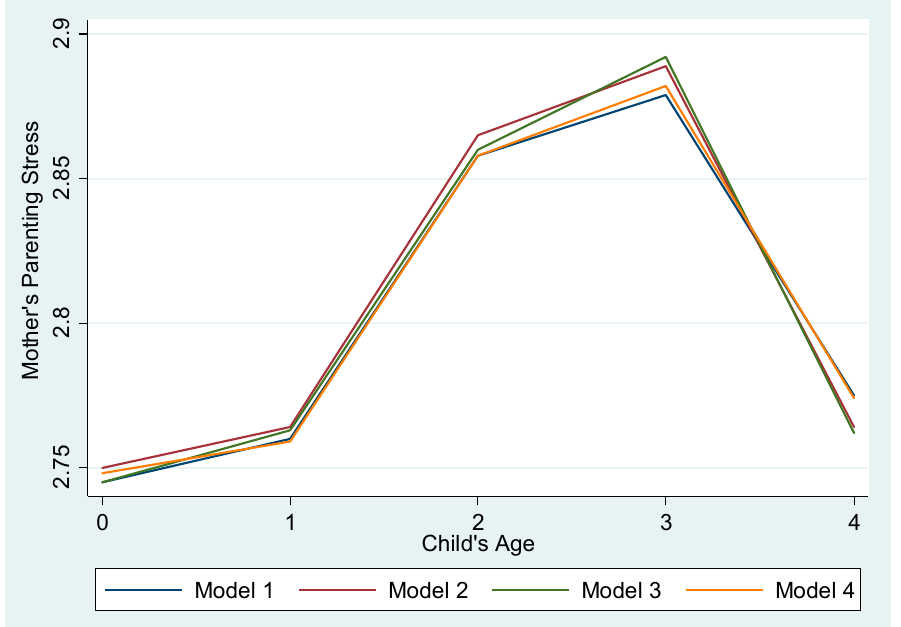
Figure 2. Predicted Mother’s Parenting Stress by Child’s Age. Model 1 represents “Childcare Facilities”, model 2 represents “Public Recreational Spaces or Facilities”, model 3 represents “Cultural Facilities”, and model 4 represents “Good Place to Raise Child in General” from Table 4.